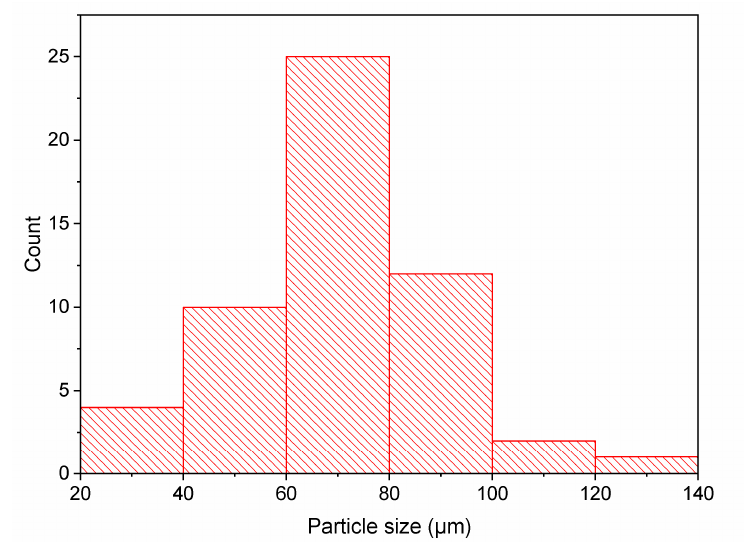
Figure 3. Particle size distribution.